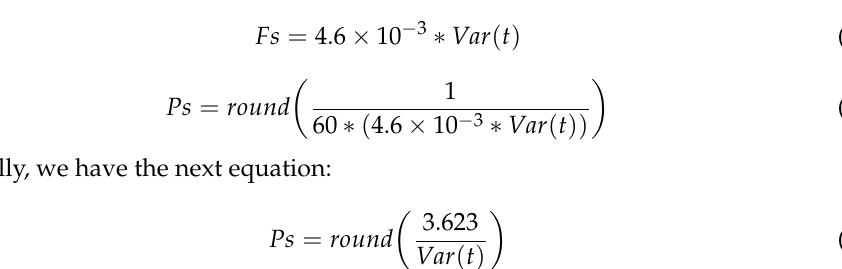
Figure 19. Best α analysis for day and mean α